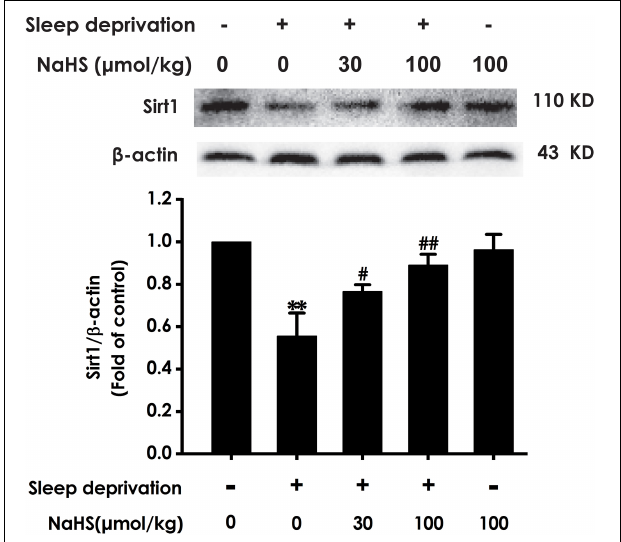
FIGURE 4 | Effect of hydrogen sulfide on the level of hippocampal Sirt1 in sleep deprivation-exposed rats. Rats were pretreated with NaHS (30 and 100 µ mol/kg/d, ip) for 7 days and then cotreated with SD for 72 h. The expression of hippocampal Sirt1 was measured by western blotting. Values are the means ± SEM ( n = 3–4). ∗∗ P < 0.01, vs. control; # P < 0.05, ## P < 0.01, vs. SD-treated alone group.